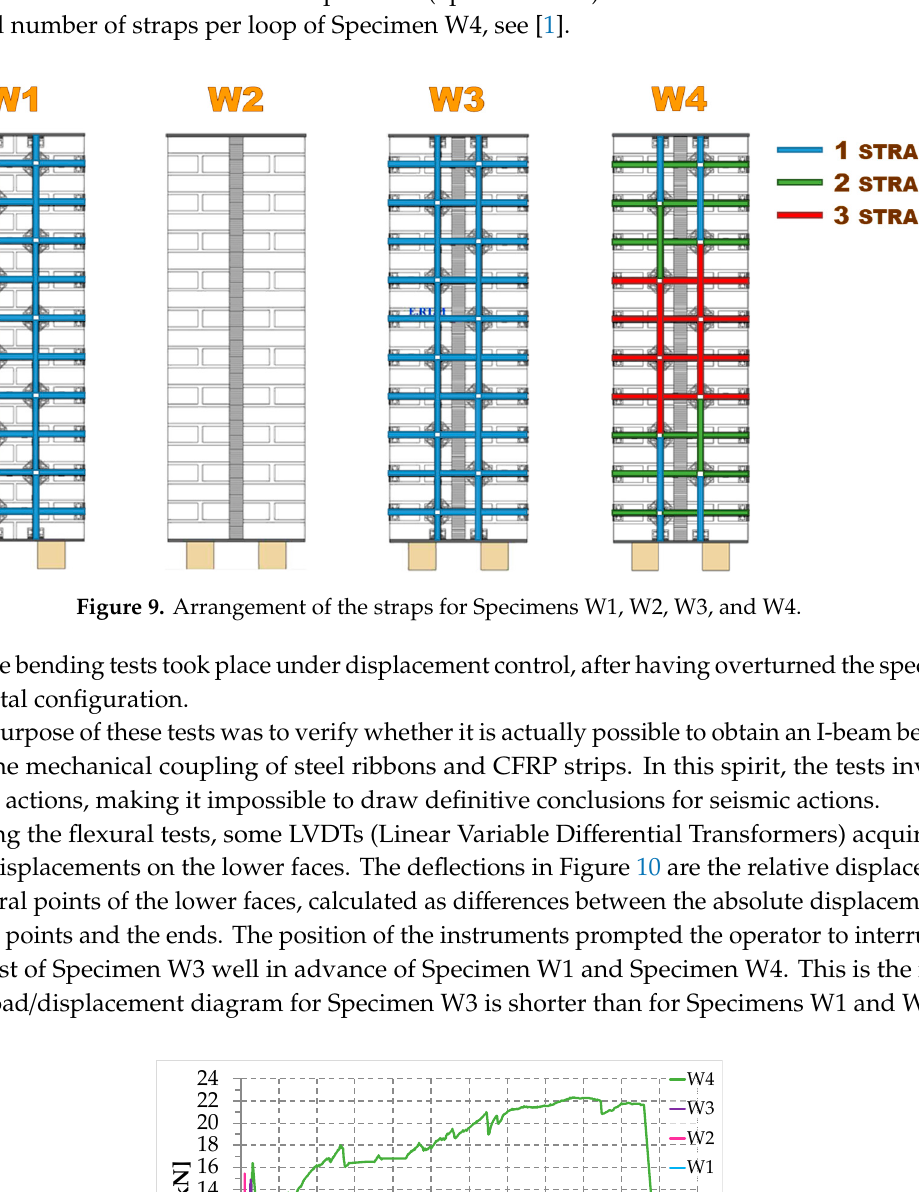
Figure 9. Arrangement of the straps for Specimens W1, W2, W3, and W4. Figure 10. The load/deflection diagrams for the four specimens of the experimentation on the first combined technique.